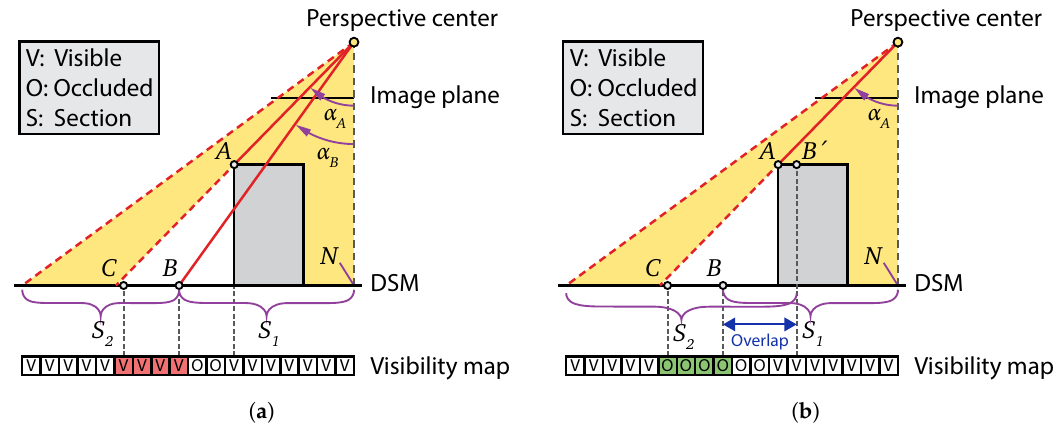
Figure 10. ( a ) False visibility reported within the adaptive radial sweep method, and ( b ) considering an overlap between two consecutive radial sections to resolve the reported false